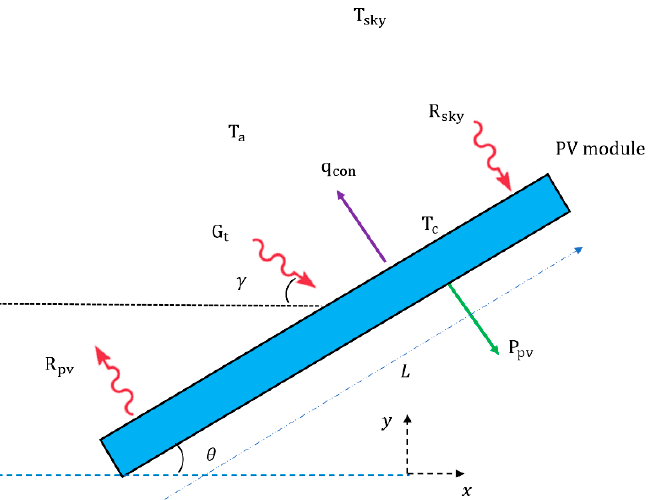
Figure 2. Schematic representation of energy gained and generated by the PV module.